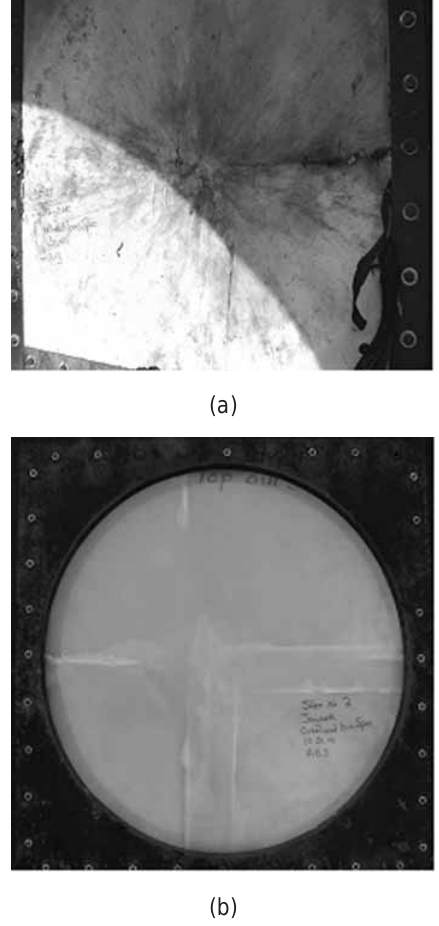
Fig. 5. Panel 2 after shock holing test. (a) Inside view; (b) Outside